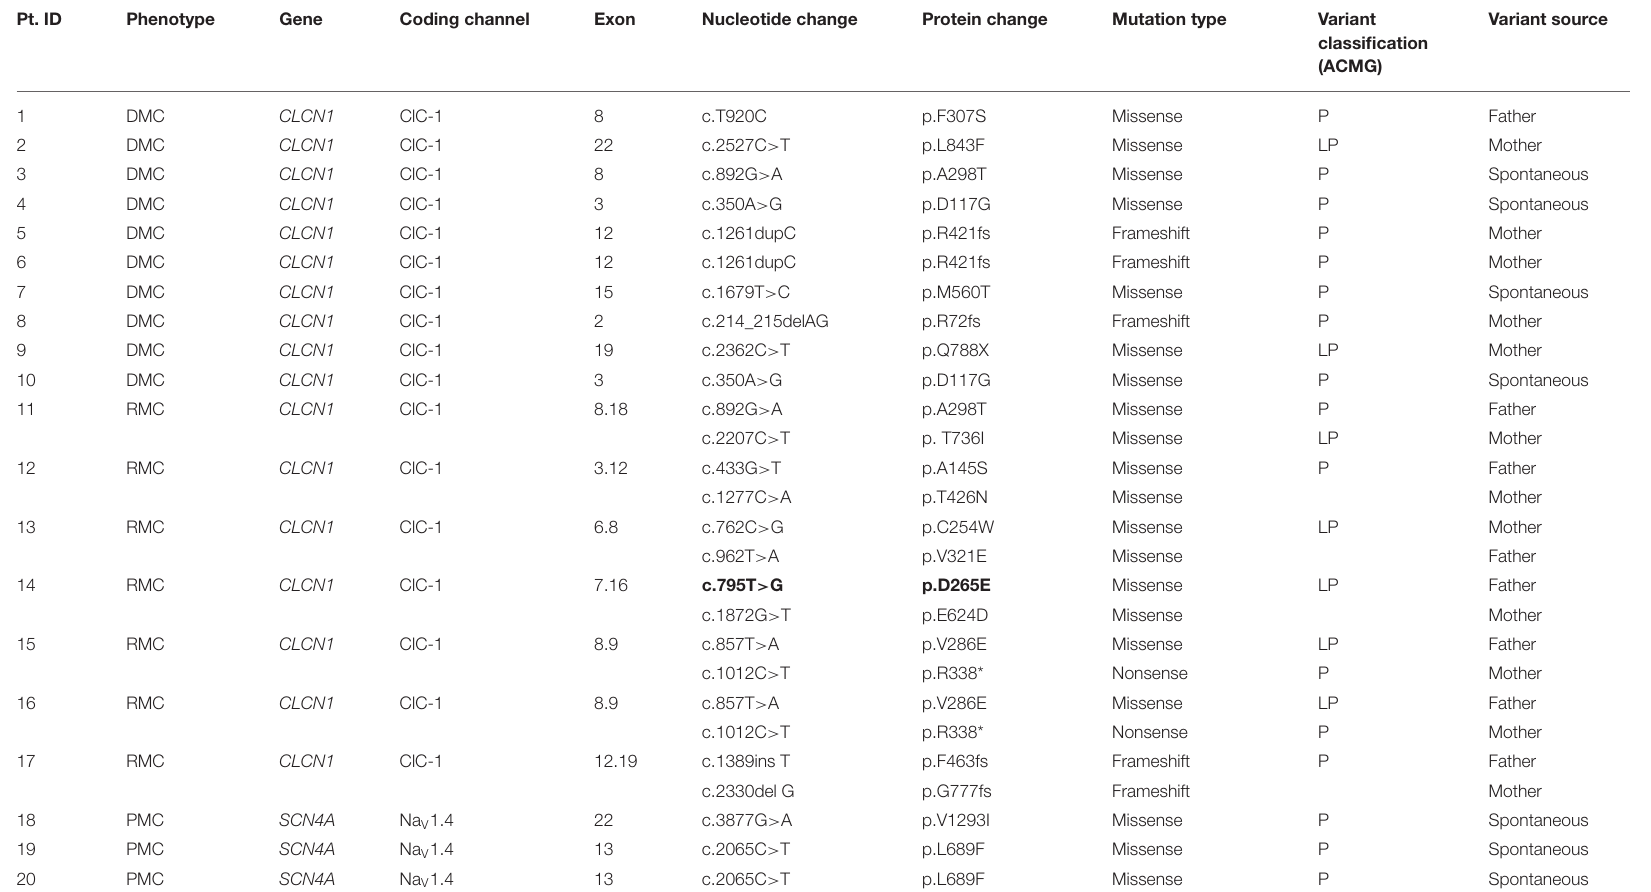
TABLE 2 | The gene mutation information of 20 patients with non-dystrophic myotonia. Pt.